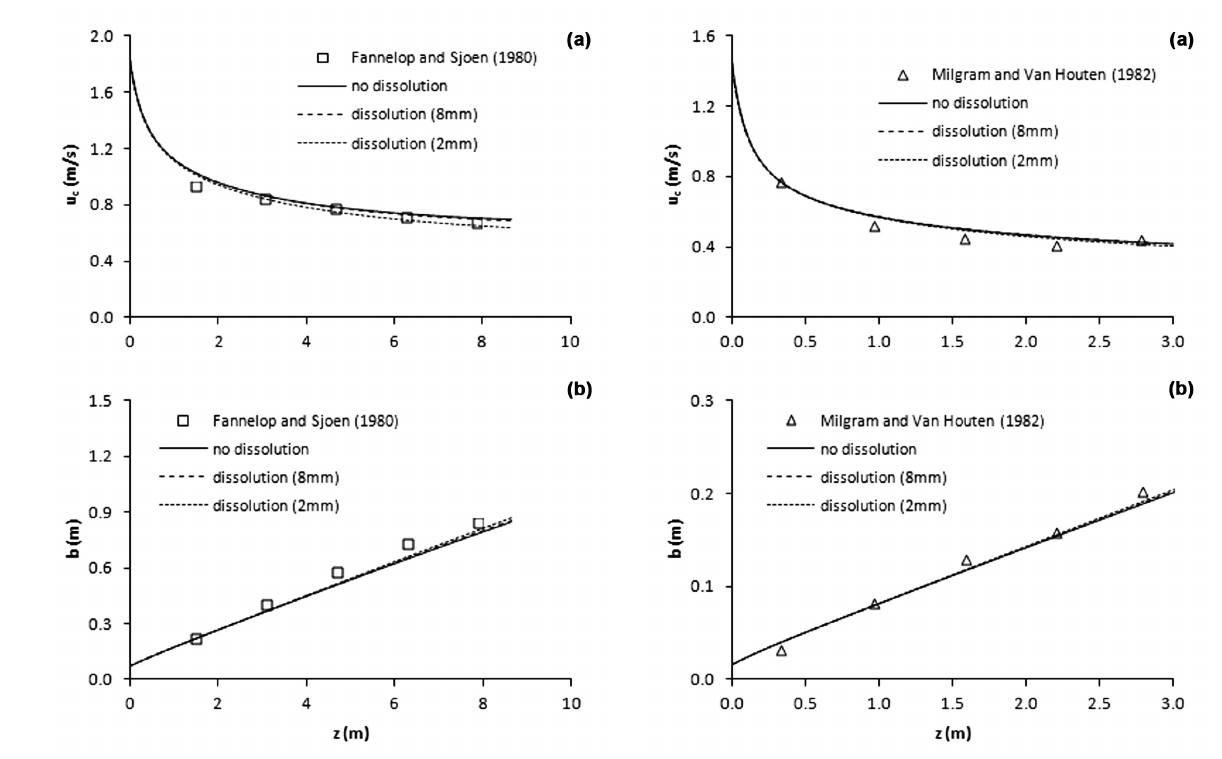
Figure 4 - Comparison between model predictions and Figure 3 - Comparison between model predictions and experimental data of Milgram and Van Houten (1982) for Q = g,a experimental data of Fannelop and Sjoen (1980) for Q = 0.0005 m 3 /s and H = 3.66 m: (a) centerline liquid velocity, and g,a d 0.01 m 3 /s and H = 10 m: (a) centerline liquid velocity, and (b) plume radius. Simulations for no dissolution and dissolution d (b) plume radius. Simulations are performed for β = 0.81, α = of air bubbles with d = 8 mm are performed for β = 0.11, α = b 0.077 and γ = 1.46, and under three conditions: no dissolution, 0.050 and γ = 2.09, and under three conditions: no dissolution, and dissolution of air bubbles with diameters d of 2 and 8 mm. and dissolution of air bubbles with diameters d of 2 and 8 b b